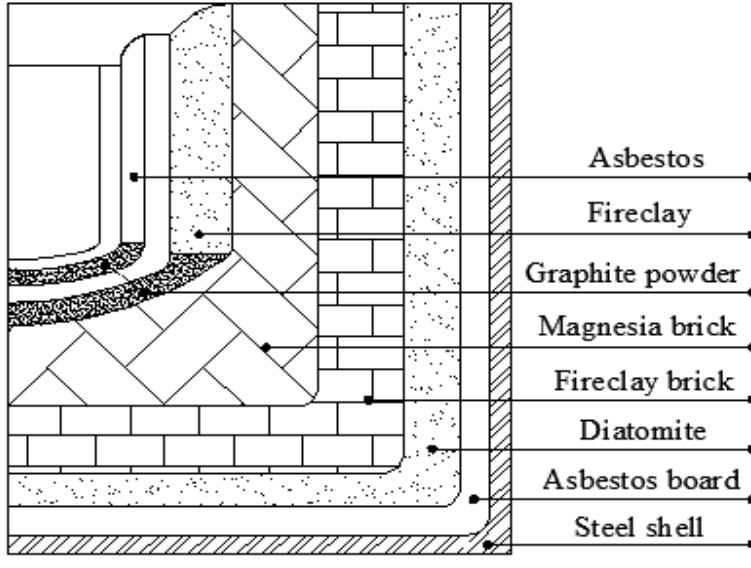
Figure 9. Illustration of the furnace lining with refractory materials.